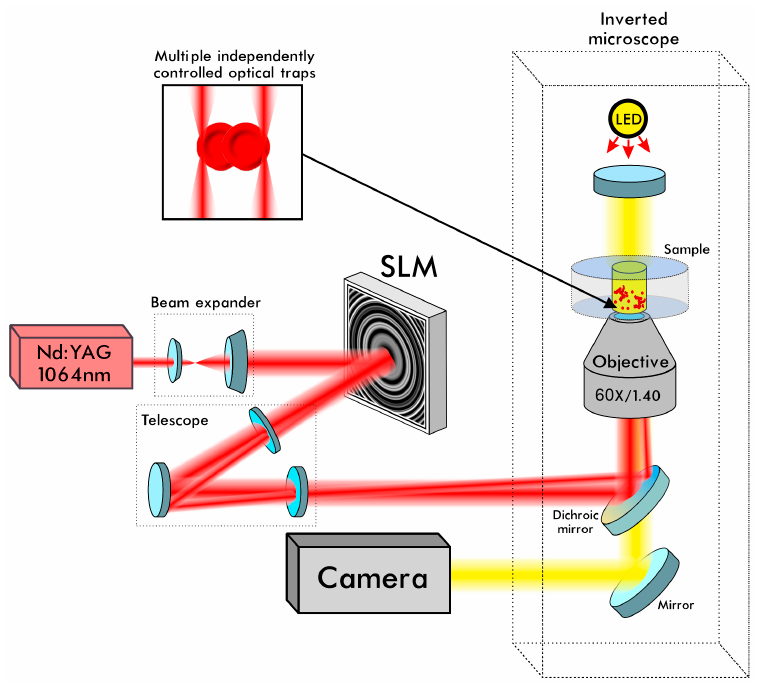
Figure 2. Schematic layout of the holographic laser tweezers for the RBC interaction force measurements. LED—light-emitting diode; SLM—spatial light modulator.